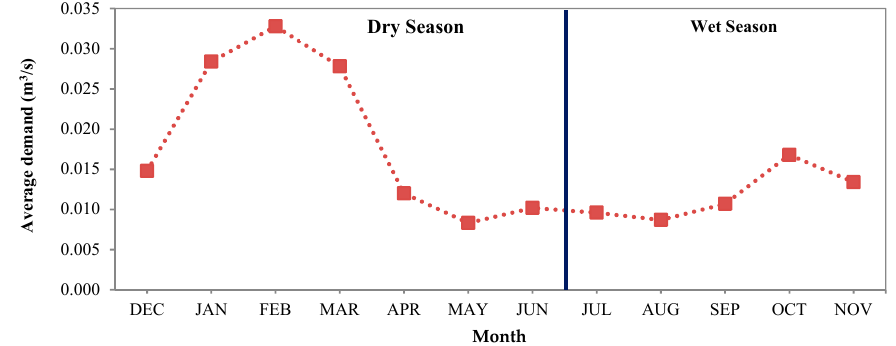
Figure 5. Average monthly water requirement for crop production.